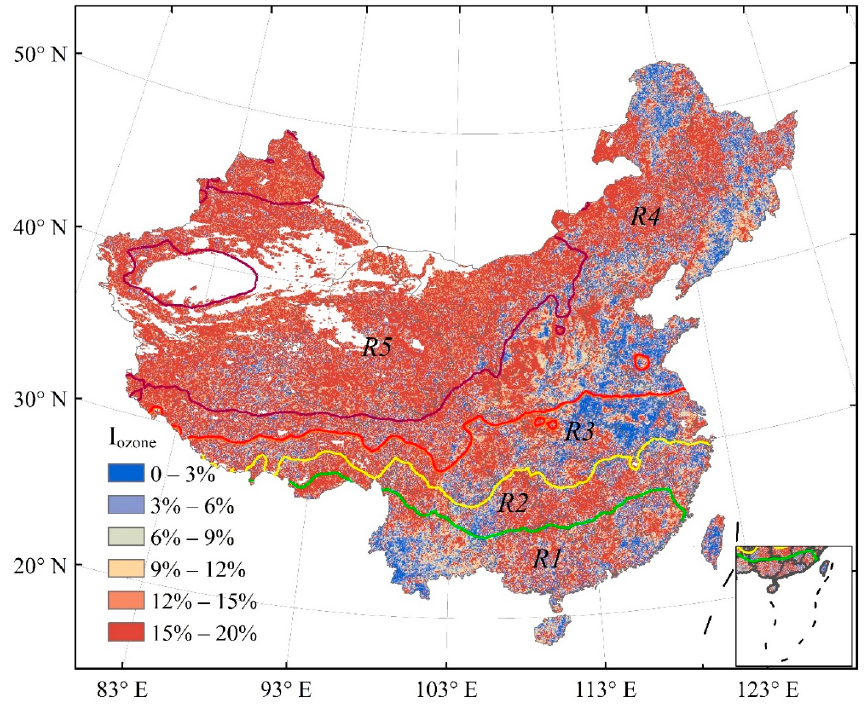
Figure 8. The spatial distribution of effects ( I ozone ) from ozone pollution on vegetation activity in the growing season from 1982 to 2020. The colored lines from south to north refer to the contour lines of OMR values of 650, 700, 750 and 800 kg/kg, respectively. The author used the software of ArcGIS 10.5 to produce the figure. Table 3. Effects of ozone pollution ( I ozone ) on vegetation growth in China. The unit is %.